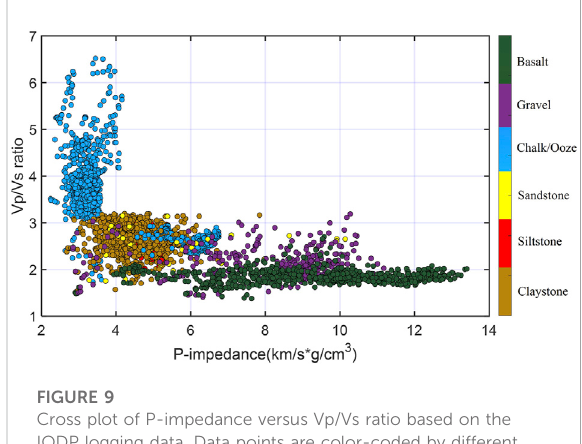
Cross plot of P-impedance versus Vp/Vs ratio based on the IODP logging data. Data points are color-coded by different lithofacies including- basalt, gravel, chalk/ooze, sandstone, siltstone, and claystone from different IODP Sites U1499,U1502, and